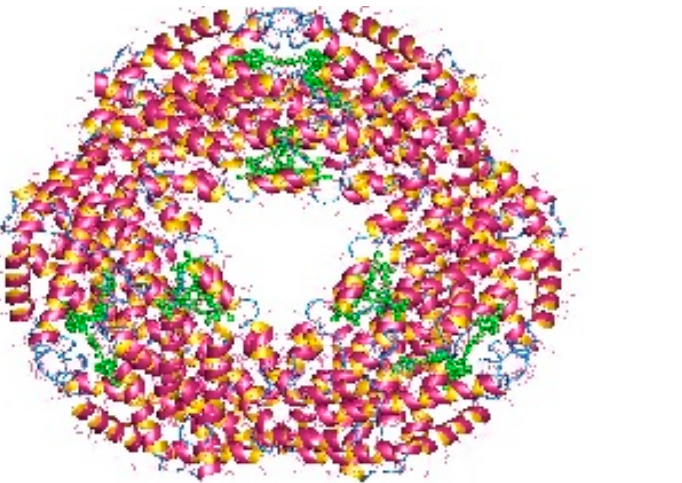
Figure 4. Allophycocyanin dodecamer (available online on https://en.wikipedia.org/wiki/Allophy- cocyanin, accessed on 14 November 2022).